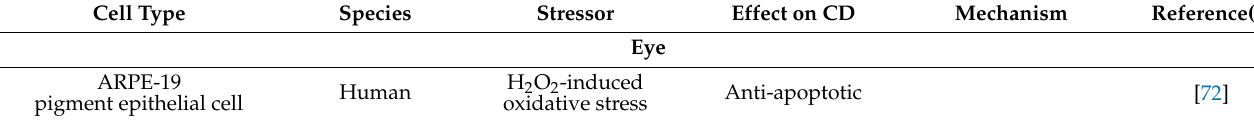
Table 2. Effects of exogenous PACAP in vitro on cell death (CD) in the sensory organs. In case the type of cell death was not specified in the cited study, the term “cell death” was